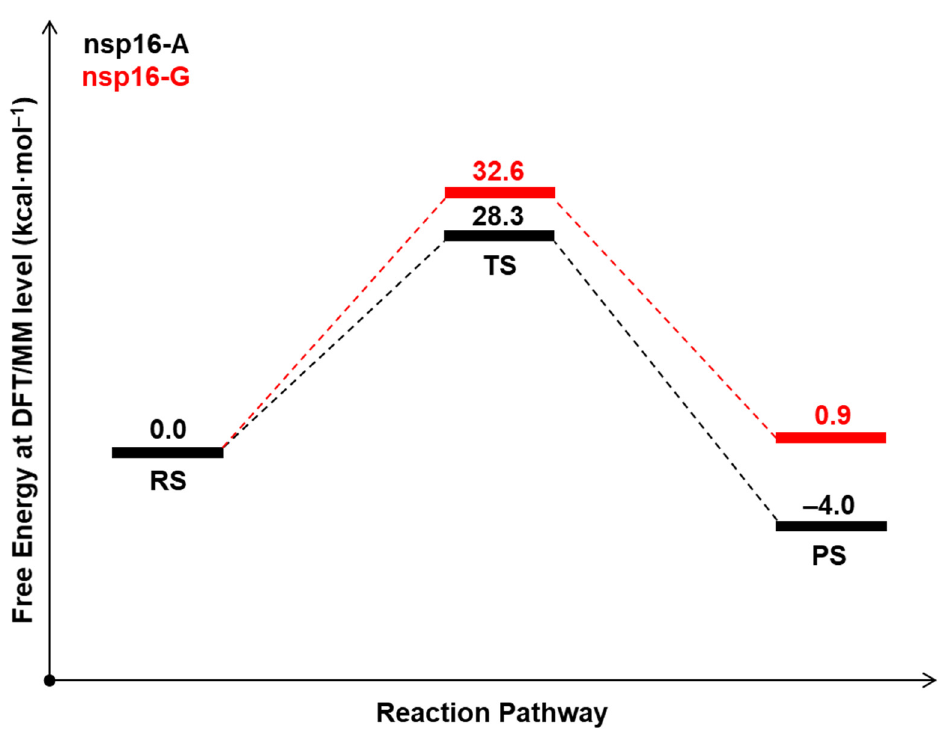
Figure 3. The free energy profile (in kcal·mol − 1 ) for the S N 2 mechanism at M062X-D3/MM level for the nsp16-A (black) and nsp16-G (red) systems.